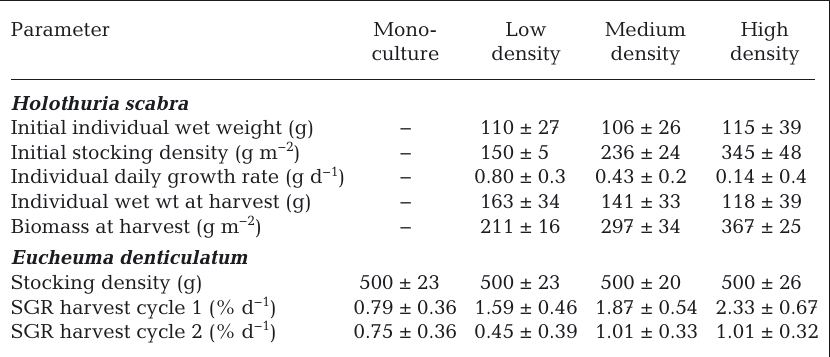
Table 2. Summary of integrated mariculture set up and growth results of seaweed Eucheuma denticulatum in monoculture and co-culture with sea cucumber